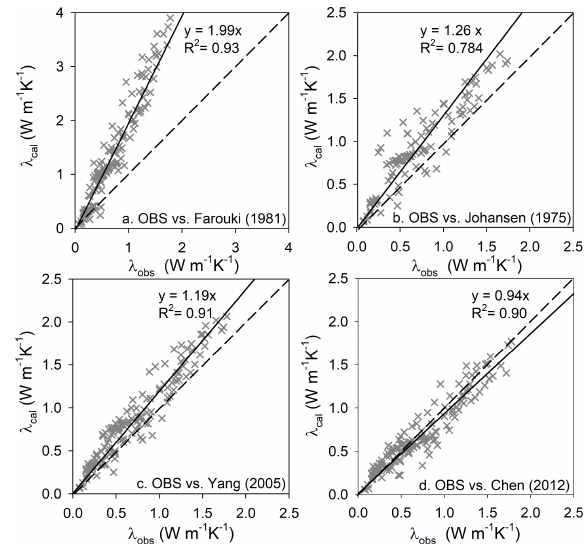
Figure 2. Comparisons of the original (CLM-ORG) and revised (CLM-KPP) CLM lake models in simulating water surface temper- ature (WST) (a) and their differences in simulating water diffusiv- ity (log10Kw) (b) in Lake Nam Co. The figure is reproduced from Zhang et al. (2019).